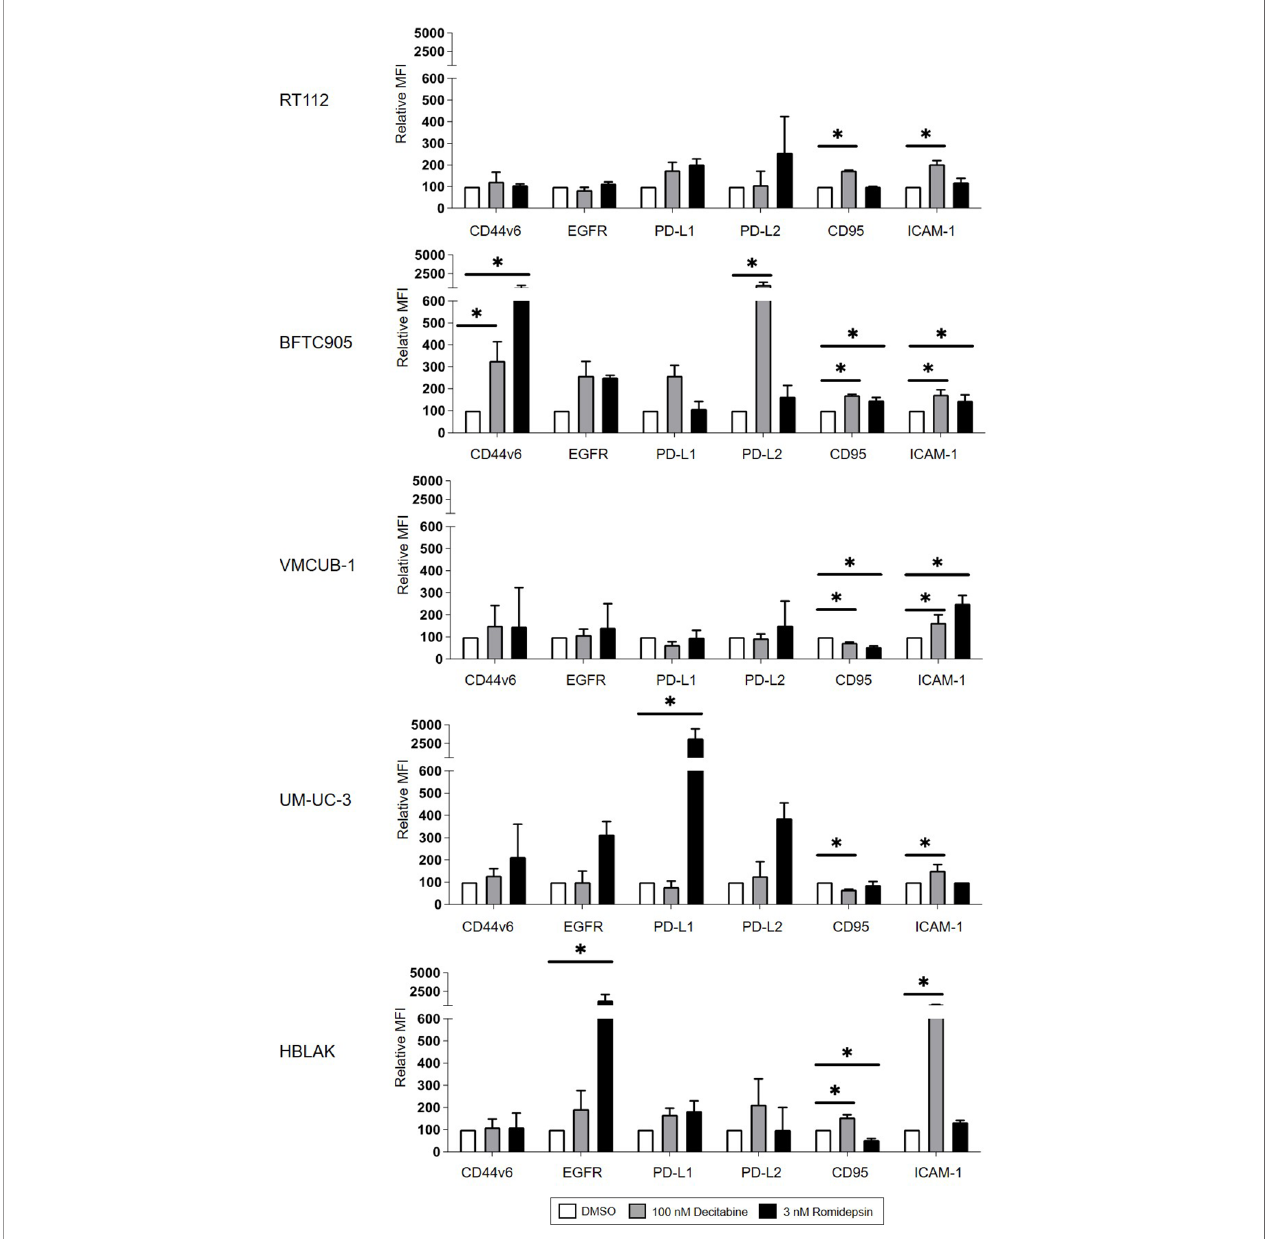
FIGURE 4 | Cell surface protein expression of CD44v6, EGFR, PD-L1, PD-L2, CD95, and ICAM-1 on target cells after DMSO, DEC, or ROM treatment. The graphs represent changes in median fl uorescence intensity (MFI) of each marker normalized to DMSO control. White bars represent the values for DMSO-treated cells, and gray and black bars represent results of DEC- or ROM-treated cells, respectively. Results are shown as the mean ( ± SD) of at least three independent experiments; values of unstained cells are subtracted. p-values were calculated by means of two-way ANOVA and subsequent Dunnett ’ s correction for multiple comparisons. Statistical signi fi cance (p-value ≤ 0.05) is denoted by